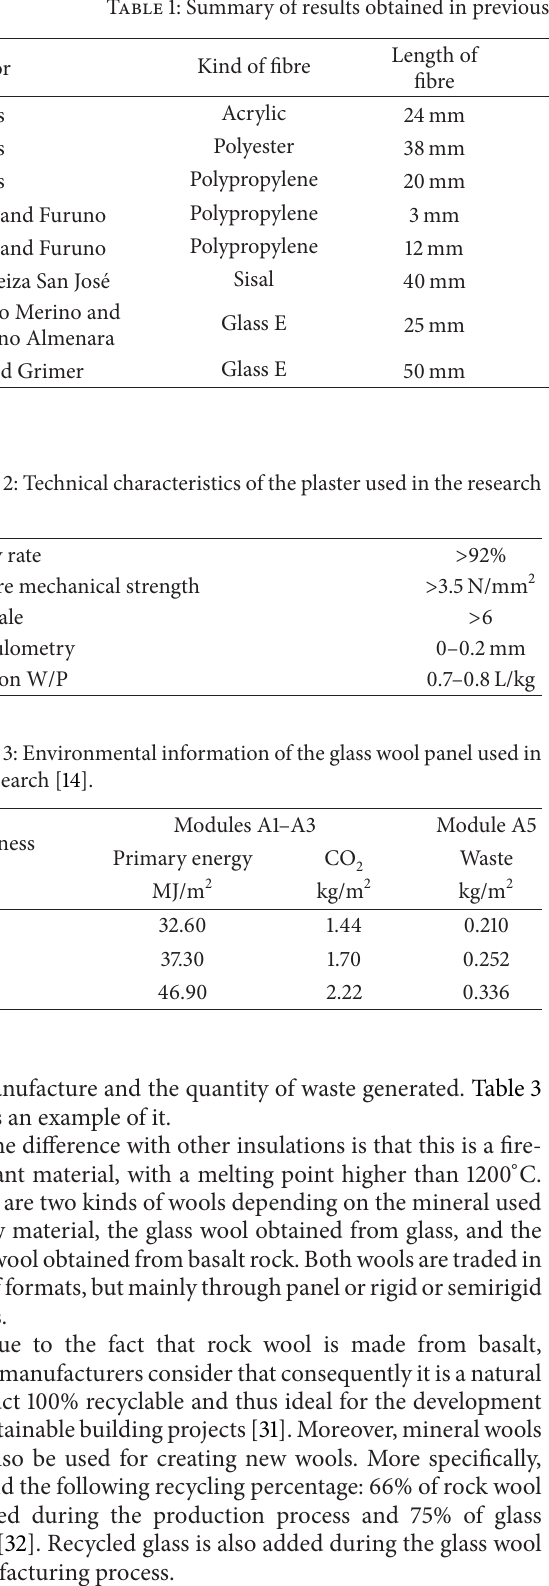
Table 1: Summary of results obtained in previous studies using fibres in plaster/gypsum matrix [7–12]. Author